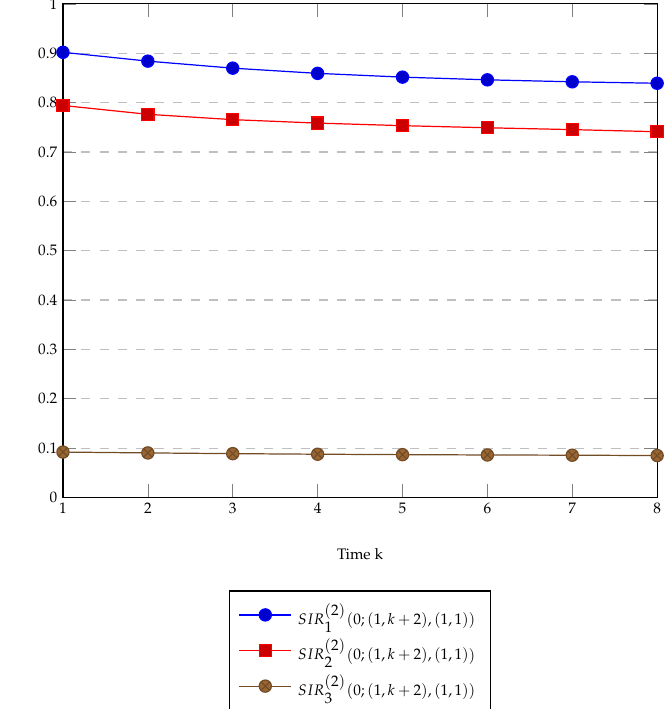
Figure 3. Sequential interval reliability plot with intervals moving apart